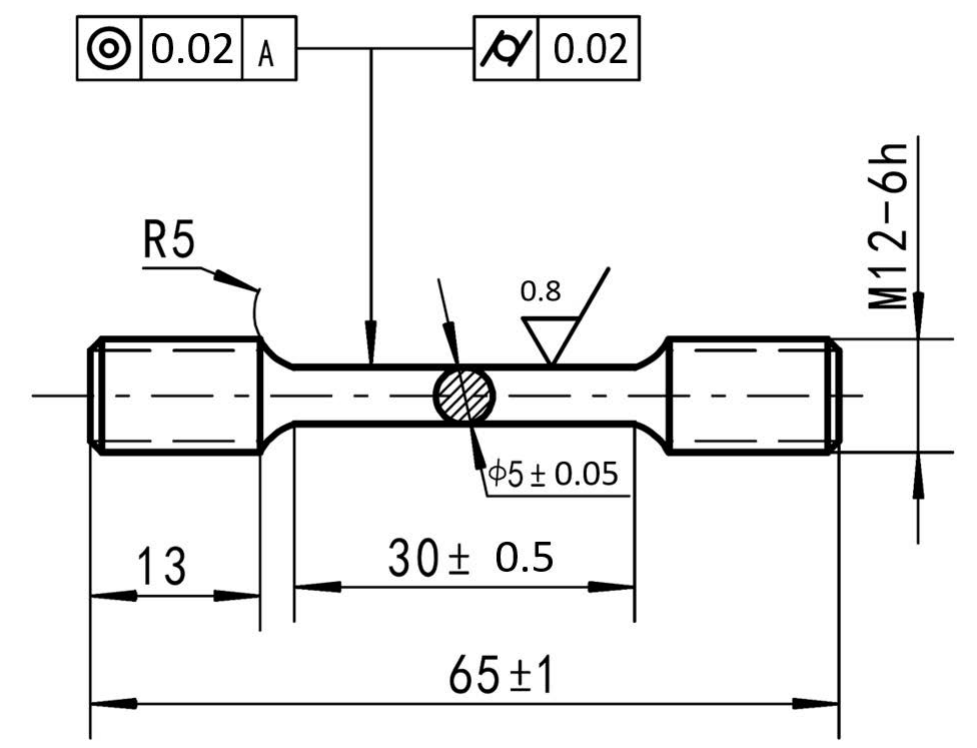
Figure 3. Size and geometry of the tensile test